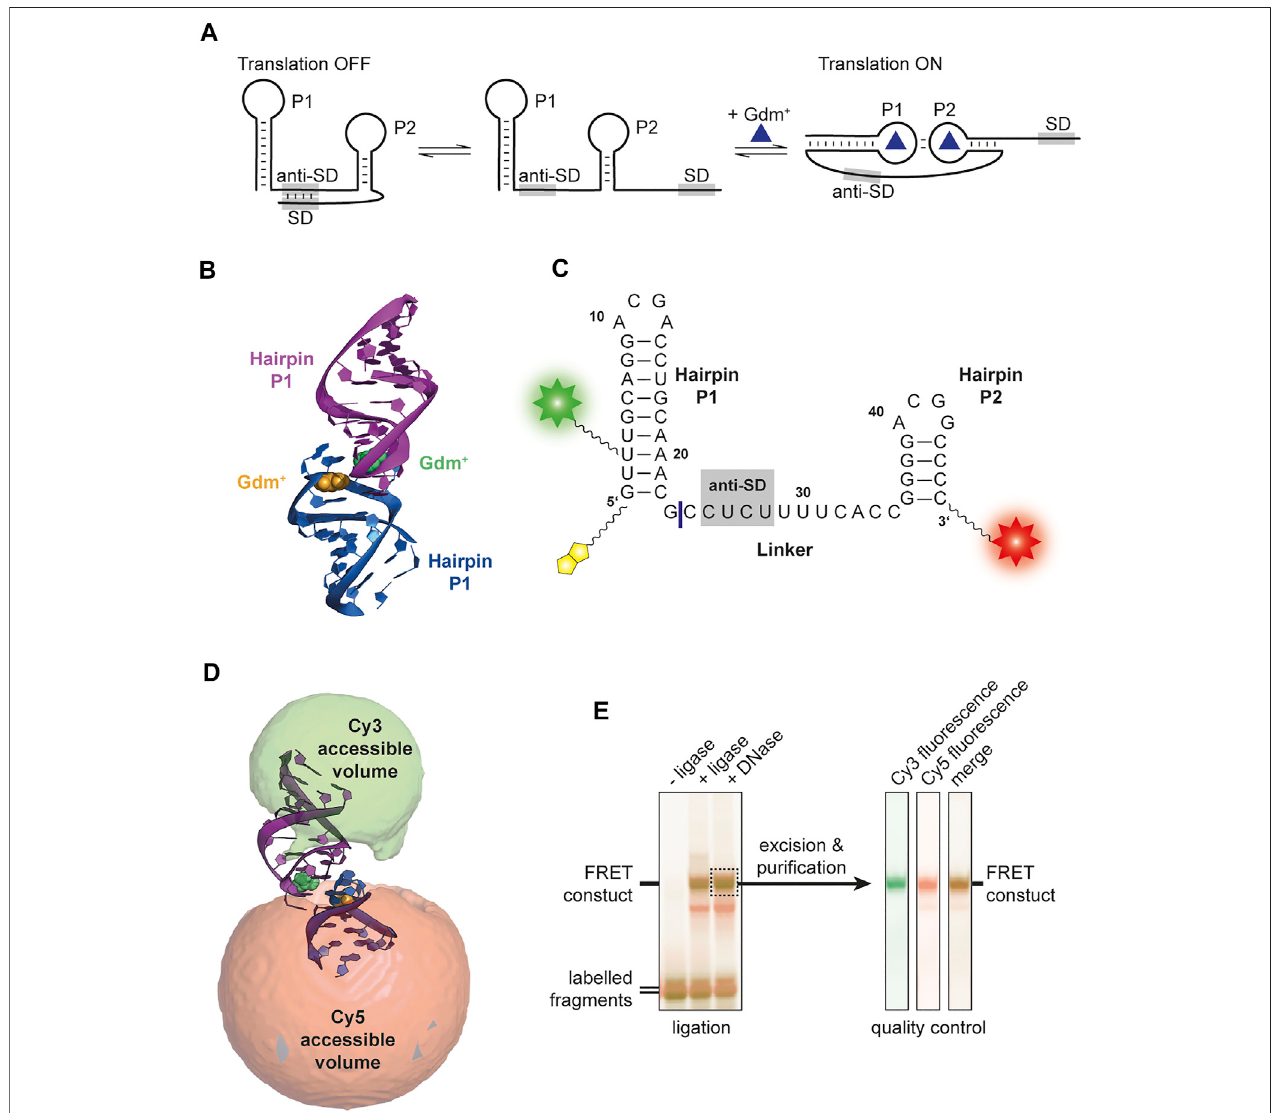
FIGURE 1 | (A) Proposed translational regulation model. Gdm + binding leads to a kissing loop interaction and sequestering of the anti-Shine-Dalgarno sequence thus allowingtranslation ofadjacent genes. (B) Crystalstructureof E.coli SugEguanidine-IIriboswitchP1homodimer(PDBID:5NDI)(Huangetal.,2017).Theindividual P1 RNA molecules are shown in blue and purple, respectively and the Gdm + ligands bound to each loop region are depicted in yellow and green. (C) Sequence of the FRET construct used in this work. The biotin moiety is illustrated in yellow and the Cy3 and Cy5 attachments sites are shown as a green and red star, respectively. The ligation site between the residues 23 and 24 is shown as a blue line. (D) Accessible volume of the Cy 3 (green) and Cy5 (red) fl uorophores calculated with FPS. One stem from the crystal structure was shortened according to the four base pairs in P2. (E) Denaturing PAGE analysis of the ligation reaction of the fl uorophore labelled 23mer and 24mer fragments to yield the FRET construct (left). The band containing the successfully ligated full length 47mer aptamer with both fl uorophores attached (dashed box) was excised and puri fi ed. Additional denaturing PAGE analysis of the dual fl uorescently labelled, puri fi ed construct used for smFRET exeriments was performed as quality control